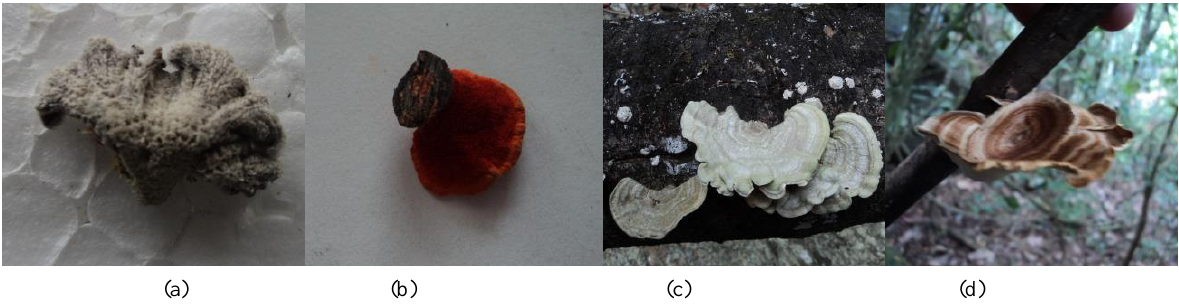
Figure 2: Some of the isolated basidiomycetes (not to scale). (a) Schizophyllum commune (M1) (~ 1/2 x), (b) Pycnoporus sp. (M21) (~ 1/4 x) (c) Trametes hirsuta (M29) (~ 1/10 x), (d) Microporus xanthopus (M25) (~ 1/10